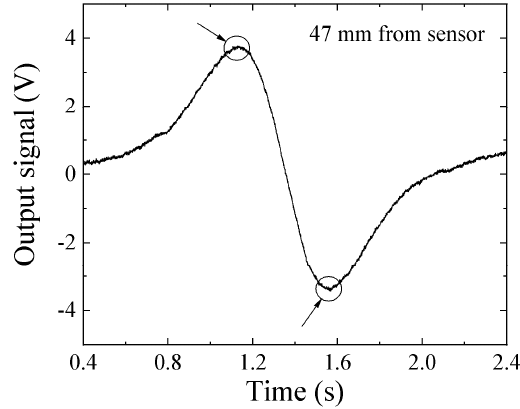
Figure 17. Measured waveform when z = 47 mm.